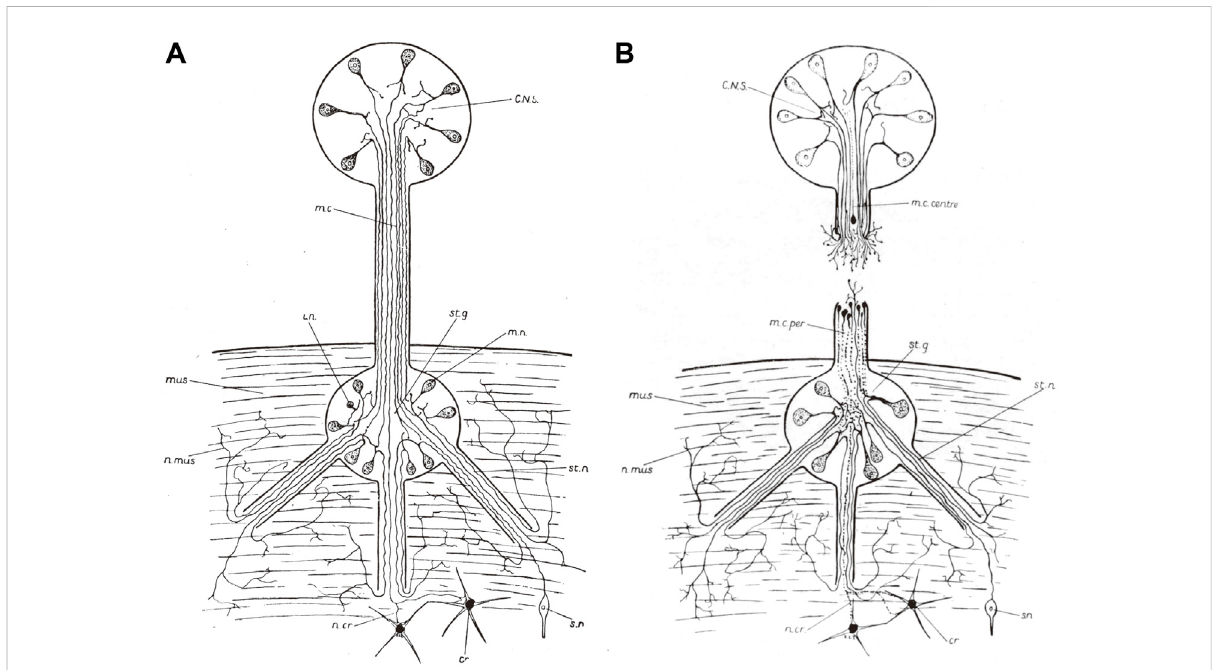
FIGURE 3 Diagrammatic drawings of pallial nerve. (A) Intact nerve. CNS , central nervous system; m. c. , pallial nerve (mantel connective, in the old terminology); i n. , intercalary neuron; st. g. , stellate ganglion; m. n. , motor neuron; mus. , mantel muscles; n. mus. , nerves to mantle; st. n. , stellar nerve; n. cr. , nerves to chromatophores; s. n. , sensory neuron. (B) Sectioned nerve in the process of regenerating. m. c. centre , central stump; m. c. per. , peripheral stump. Other lettering as in A. (Sereni and Young, 1932. Figure 1, p. 176, and 21, p. 195, respectively. © Stazione Zoologica Anton Dohrn. Reproduced by